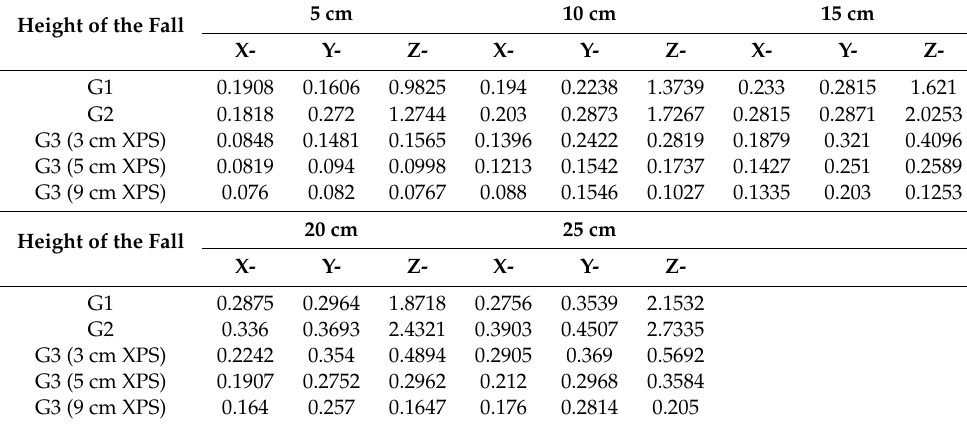
Table 4. Peak value of acceleration under di ff erent test conditions. (Unit: g).